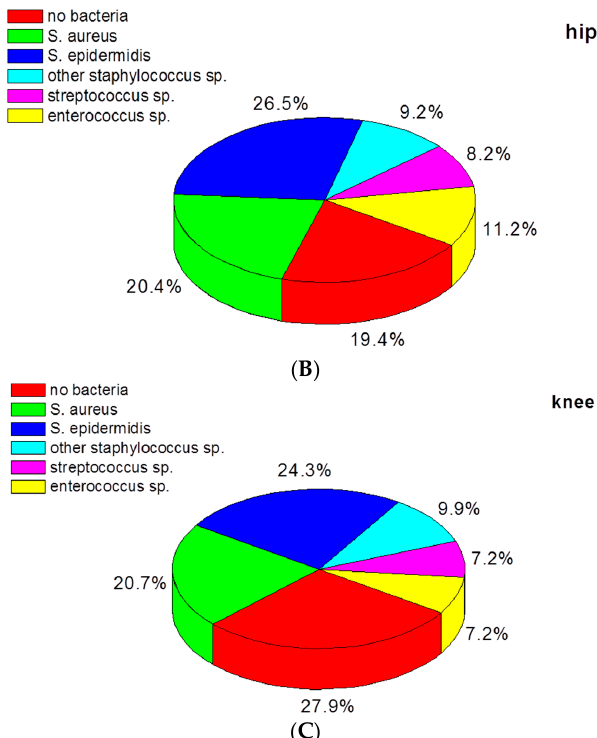
Figure 1. ( A ) Distribution of bacteria ( n = 159) detected in all patients; ( B , C ) Numbers of culture-